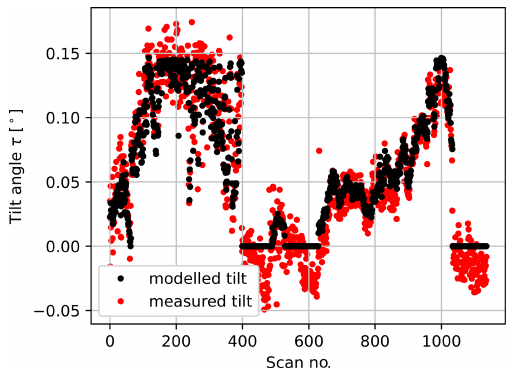
Figure 13. Comparison of the measured tilt angle τ m (red) derived from the roll ρ m and pitch φ m angles measured by the SSL and the modelled tilt angle τ mod estimated by the PTM (black) over the scan number.